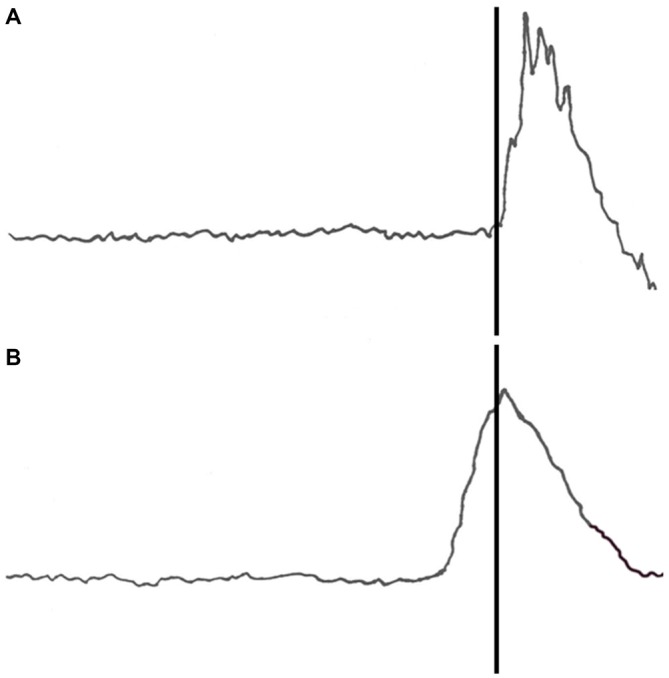
Recorded eyeblink responses from a US alone pre-exposure trial (upper panel) and a CS-US paired trial (lower panel). The eyeblink responses are filtered eyelid electromyographic (EMG) signals. The vertical line indicates the onset of the US air puff. (A) The upper panel represents an unconditioned response (UR) to the air puff on a US alone pre-exposure trial. (B) The lower panel represents a well-timed conditioned response (CR) on a tone-air puff training trial.